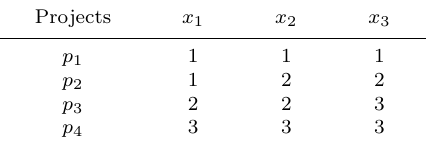
Table 7. True criteria x 1 , x 2 , x 3 values for 4 given projects.